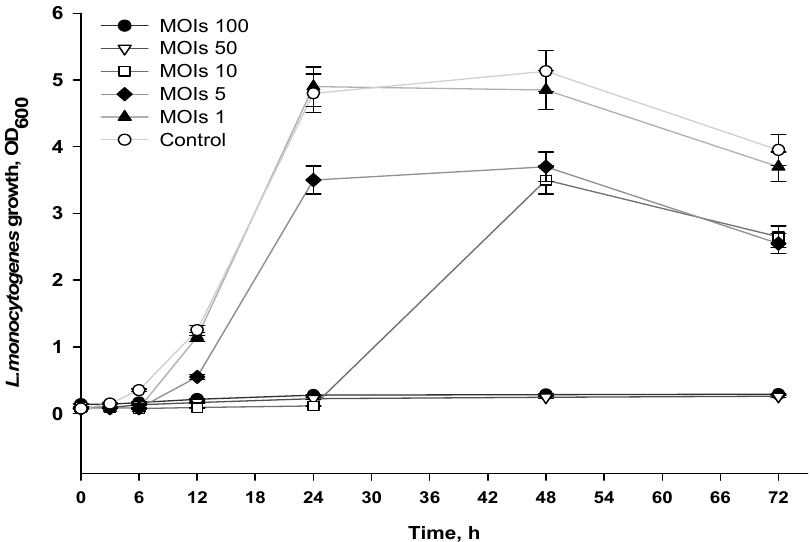
Figure 5. Antimicrobial activity of formulas applied at different MOIs.